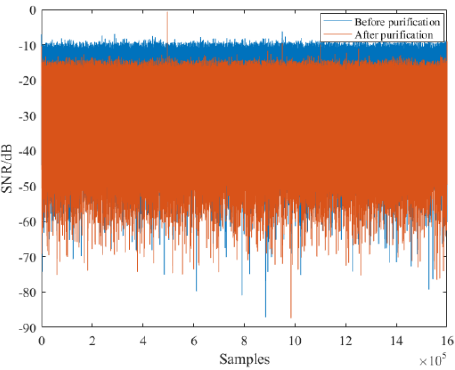
Figure 14. Spectrum comparison of reference signal before and the after purification.